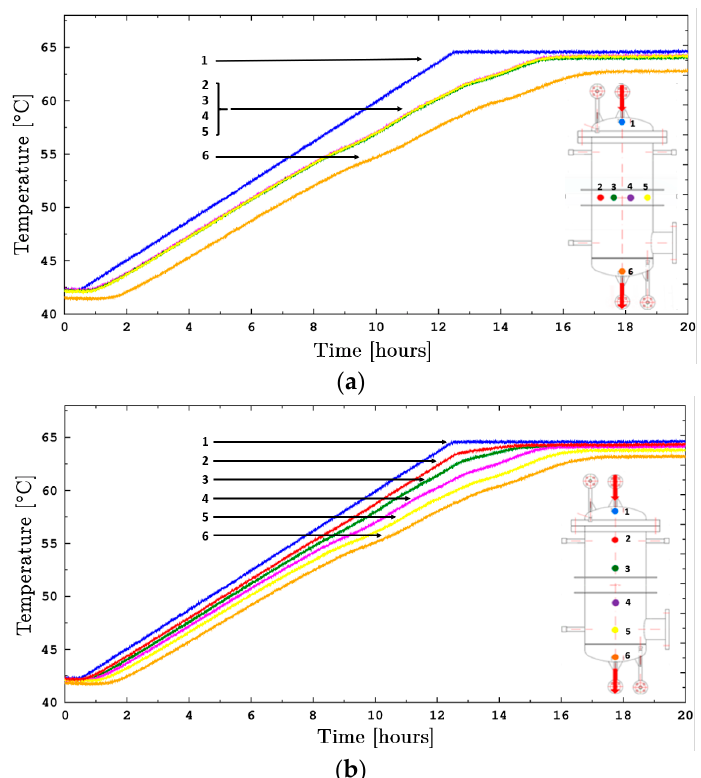
Figure 6. Evolution of temperatures vs. time for a charge between 42.3 °C and 64.6 °C at 100 L/h. ( a ) Horizontal temperature variation, ( b ) vertical temperature variation.